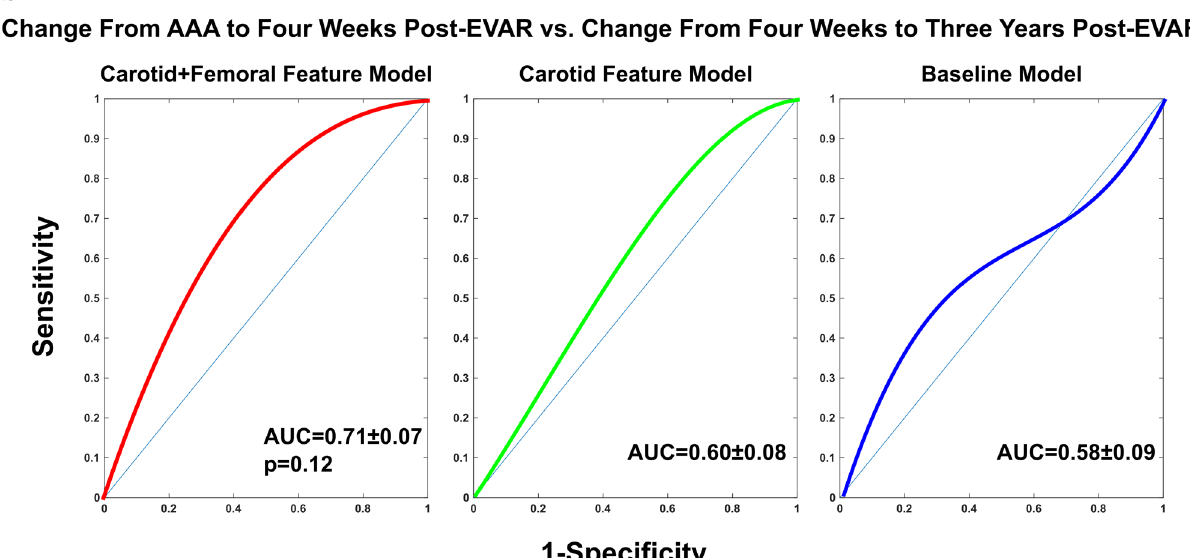
Fig. 7 Classi fi cation results of out-of-training maximal aortic diameters predicted by the three models for the AAA patients before and after EVAR. a ROC curves for classifying the AAA patients before versus 4 weeks after EVAR using the 100 predicted maximal aortic diameters. b ROC curves for classifying the change from before to 4 weeks after EVAR versus the change from 4 weeks to 3 years post-EVAR using the 34 available predicted maximal aortic diameter changes. The two-sided p -values were obtained through comparisons with the baseline model using the Hanley – McNeil test for paired